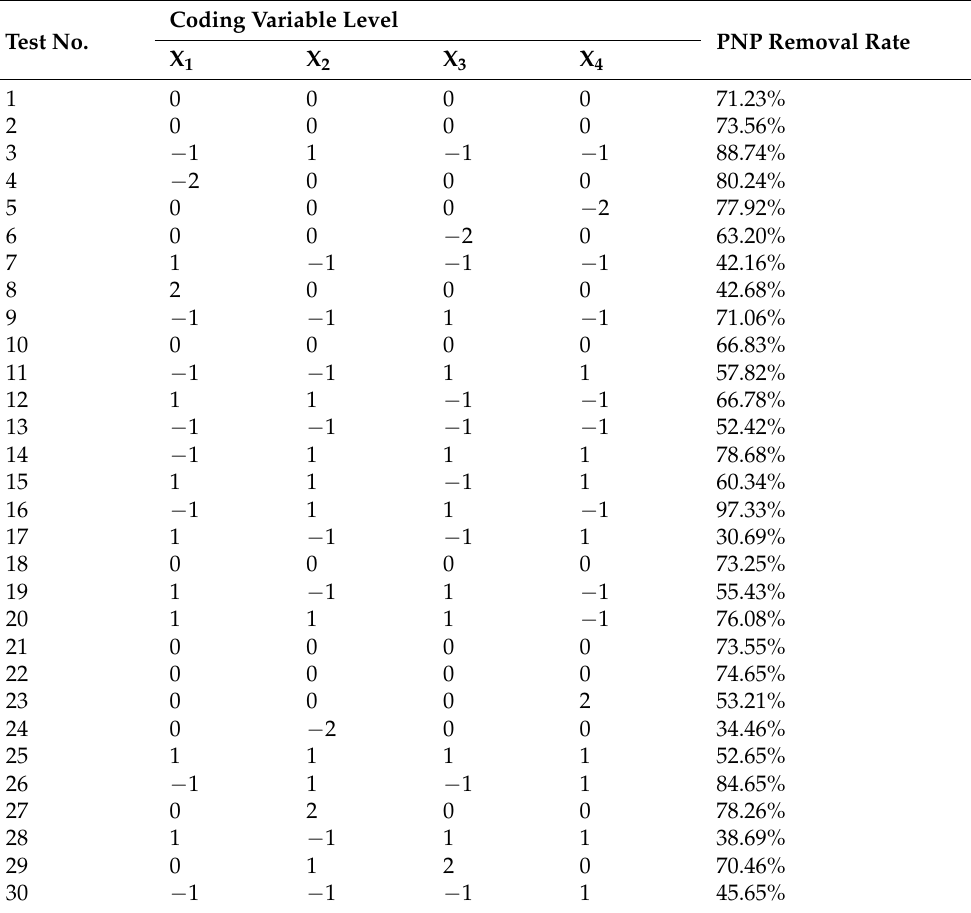
Table 2. Test design and response